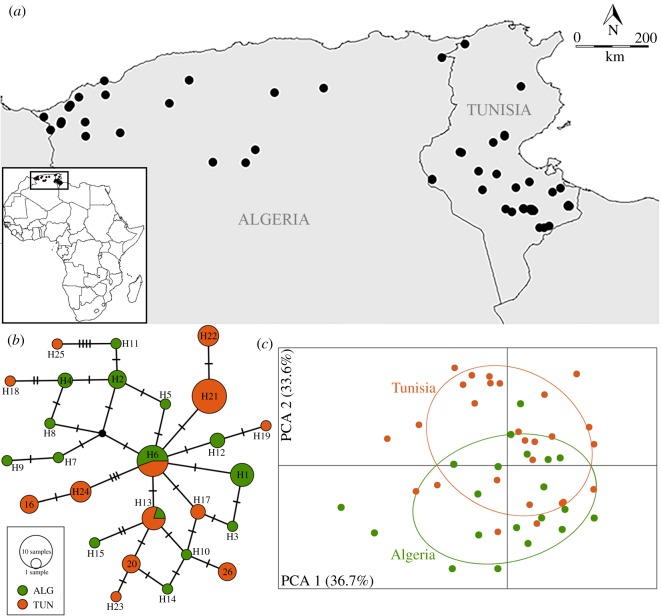
(a) Distribution of African wolf samples. (b) MJ network based on mtDNA control region, depicting relationships of African wolf haplotypes from Algeria and Tunisia. Dashes in the branches correspond to nucleotide substitutions. (c) Principal components analysis (PCA) using 47 African wolf individuals from the Northwestern population analysed for 13 microsatellites; ovals are 95% inertia ellipses for Algerian and Tunisian sampling sites.